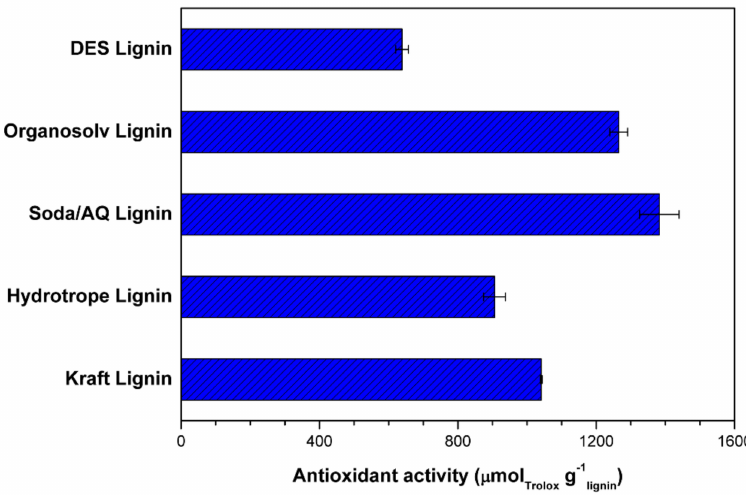
Figure 2. Antioxidant activity of these four technical lignins and Kraft lignin determined by Trolox equivalent antioxidant capacity (TEAC)